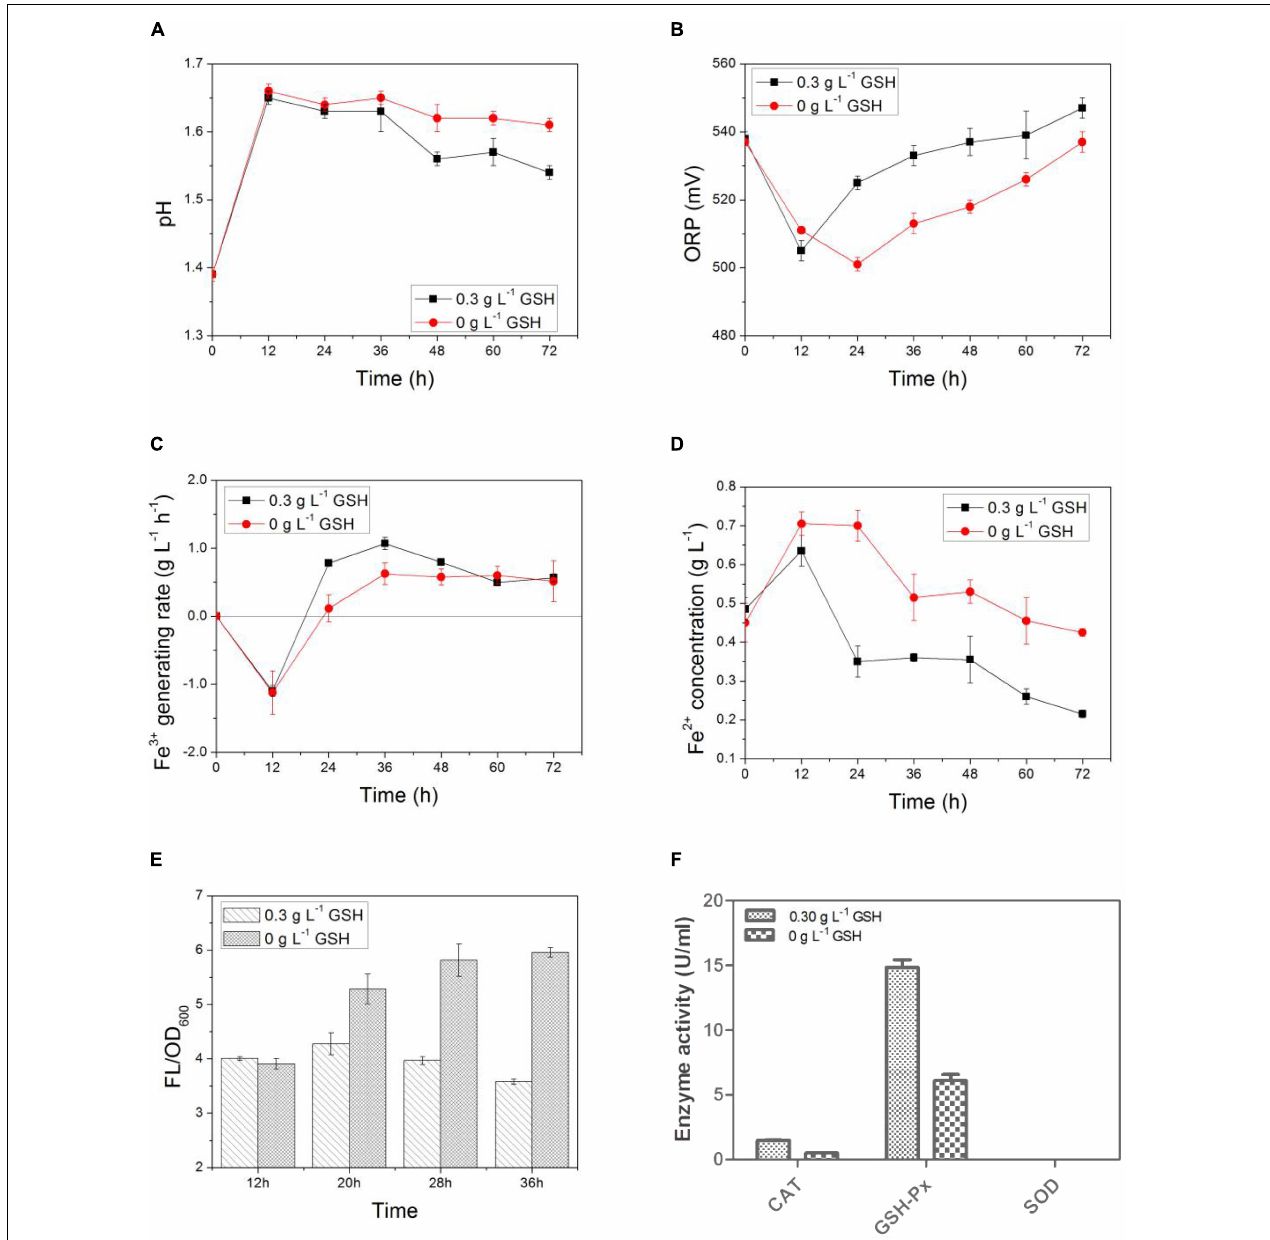
FIGURE 7 | Time-courses for (A) pH, (B) ORP, (C) Fe 3 + generation rate, (D) Fe 2 + concentration, (E) ROS content, and (F) activities of intracellular ROS scavenging enzyme by exogenous GSH for simulated bioleaching system with 4.0% (w · v − 1 ) pulp density of LiCoO 2